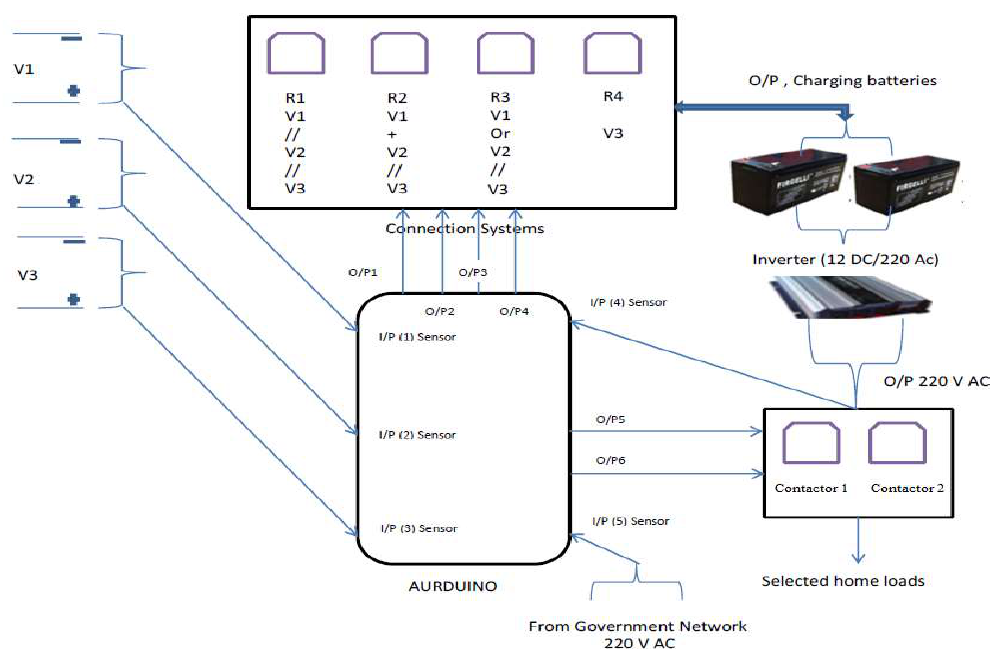
Figure 3. The integrated generated power model.